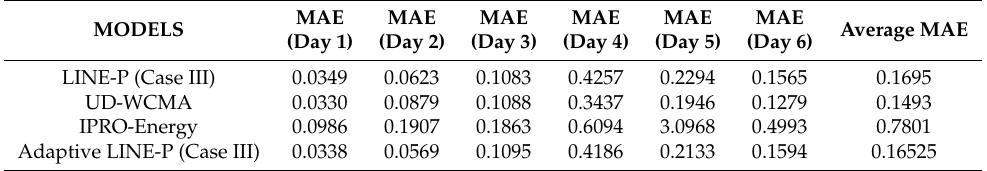
Table 14. Error comparison of the energy prediction models in terms of MAE for the wind energy profile.